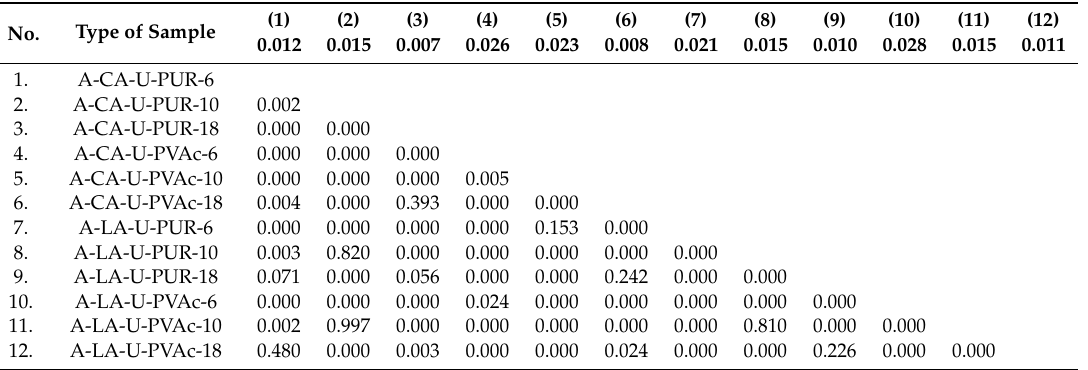
Table 24. Comparison of the e ff ects of individual factors using Duncan’s test on the coe ffi cient of bendability ( K bendB ) for aspen and NWC on top.